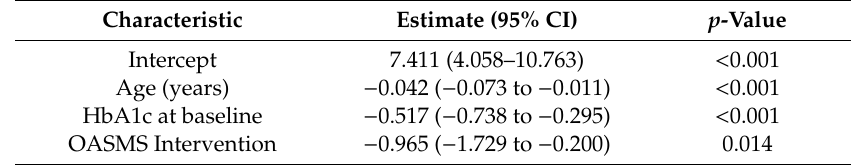
Table 4. Multivariable linear regression for the most significant predictors of HbA1c